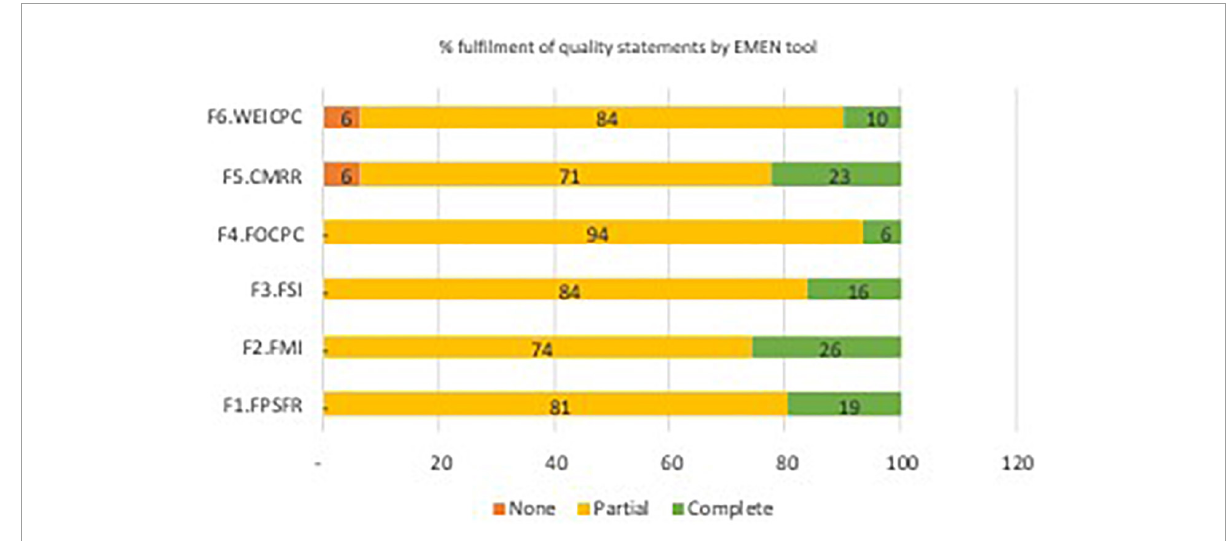
FIGURE4 Fulfilment of quality statements by